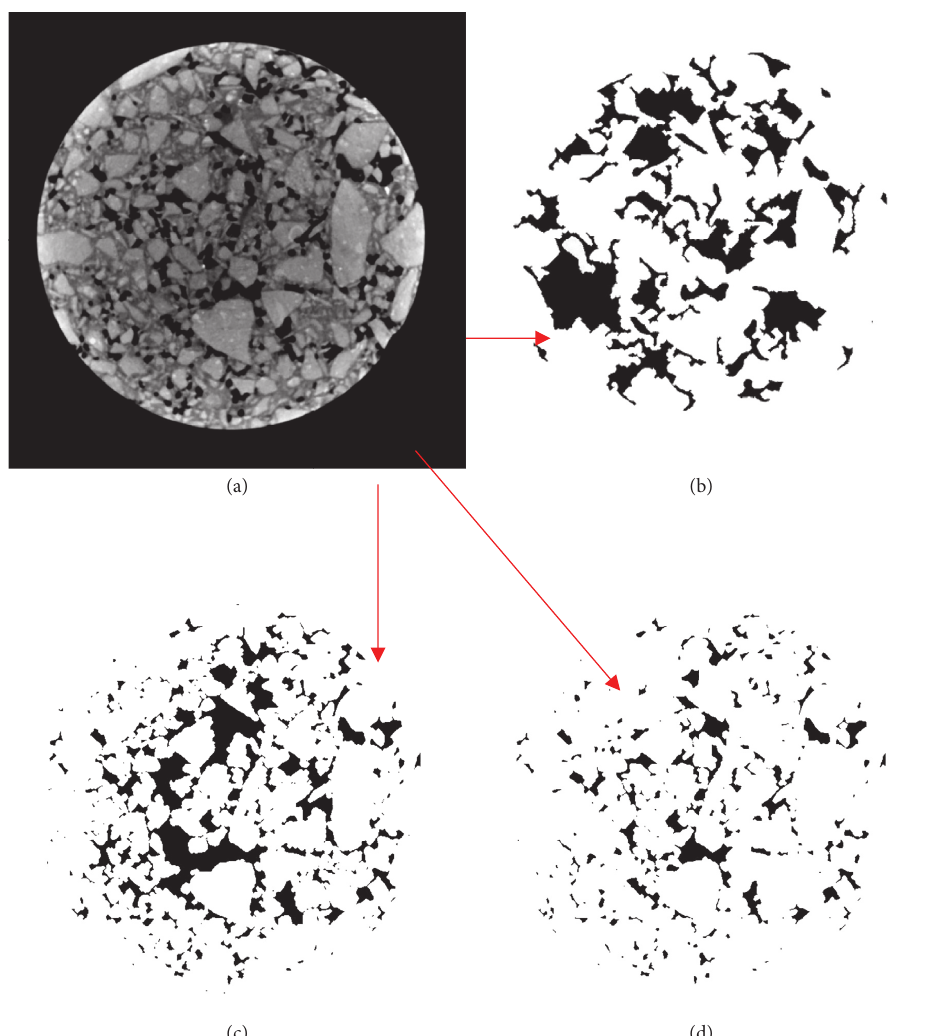
Figure 4: Comparisons among Bernsen, conventional Otsu, and ring blocking using Otsu’s method. (a) Original CTpicture. (b) Processed using Bernsen method. (c) Processed using conventional Otsu’s method. (d) Processed using ring blocking using Otsu’s